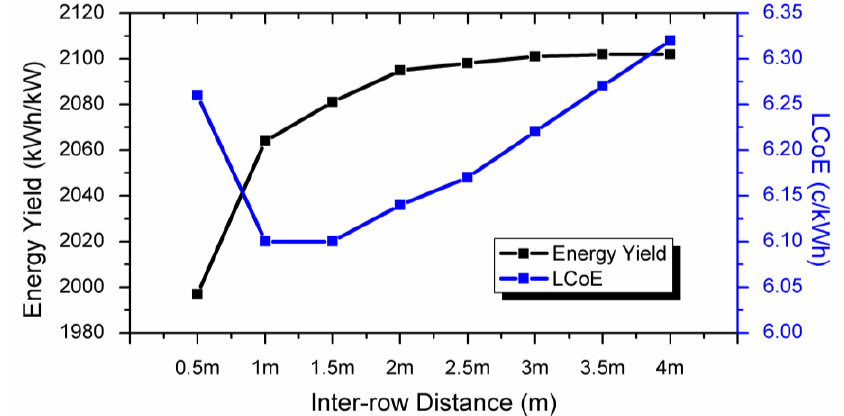
Figure 7. Energy yield and levelized cost of energy (LCoE) of the ground-mounted PV configuration.